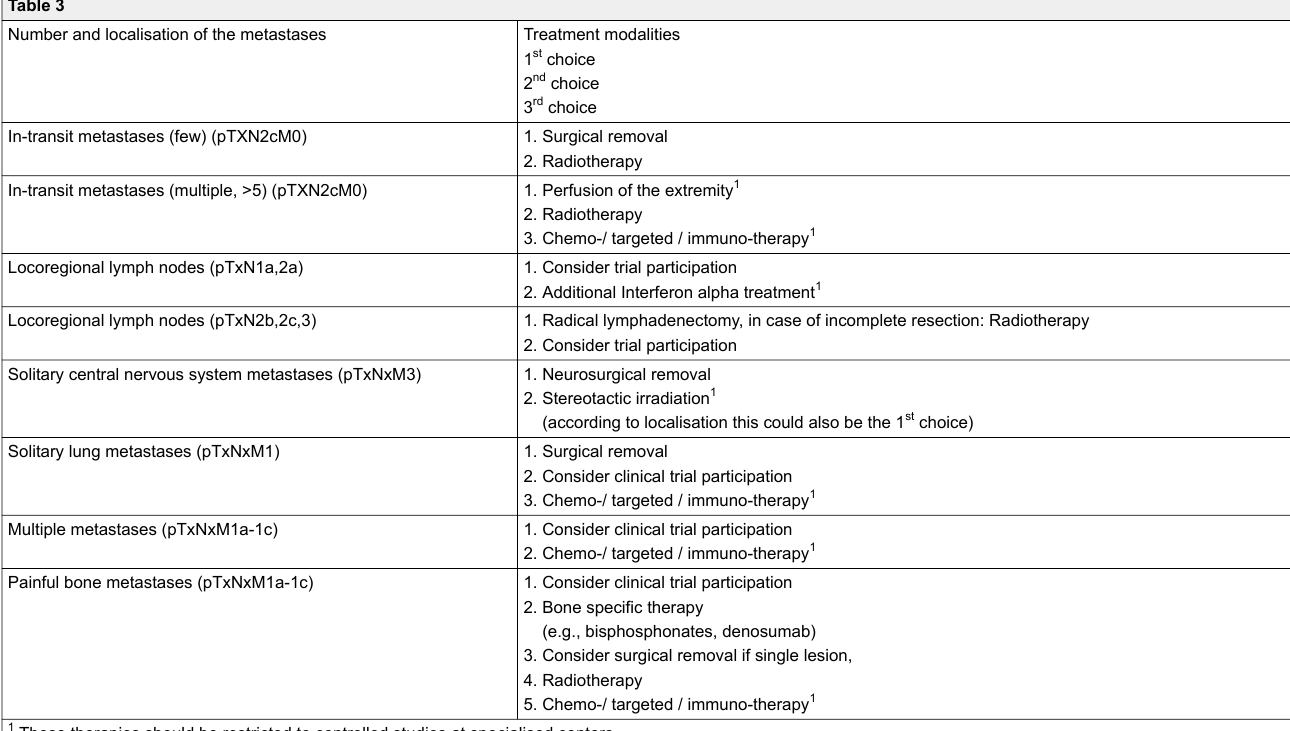
Number and localisation of the metastases Treatment modalities